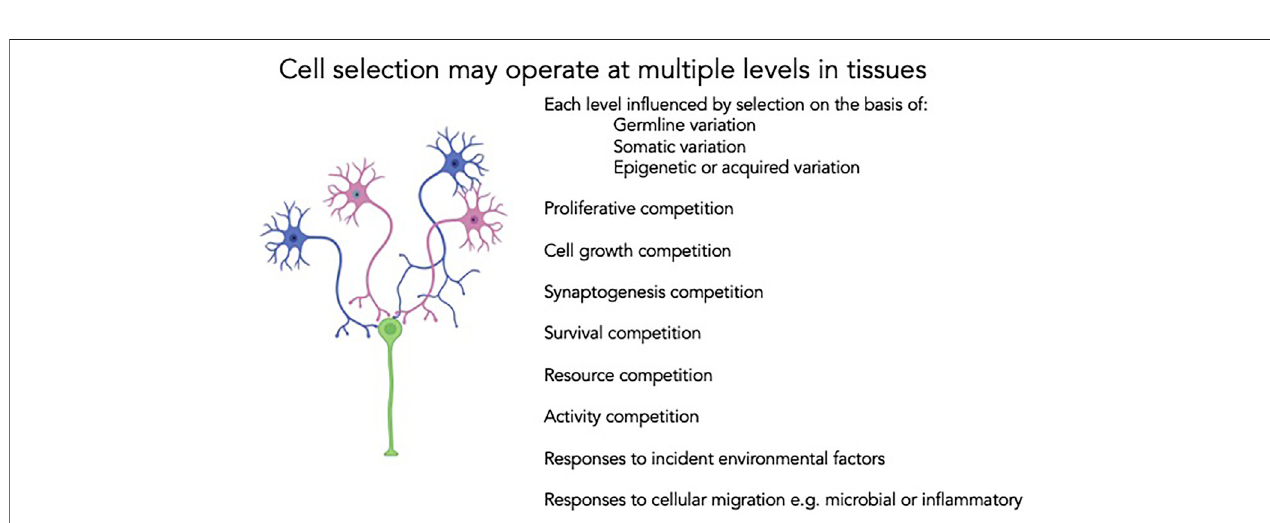
FIGURE 2 | Cell competition is also feasible in terminally differentiated cell lineages. Neurons may undergo selective pressures at multiple stages of their life cycle. Proliferative advantages for individual clones may be reinforced or counteracted in subsequent competition for synaptogenesis with other cells in neuronal circuits, activity-based functional inputs or differential susceptibility to ischemia, in fl ammation or other external pressures. The net output of the system, and the penetrance and expressivity of germline genotype, is a re fl ection of each of these levels of selection. A more rigorous appraisal of the discrete steps and the operant selection pressures will enable improved diagnosis, prognostication and